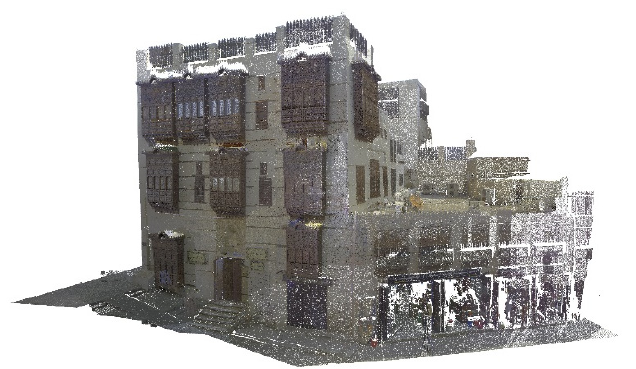
Figure 7. Three-dimensional colored point cloud.